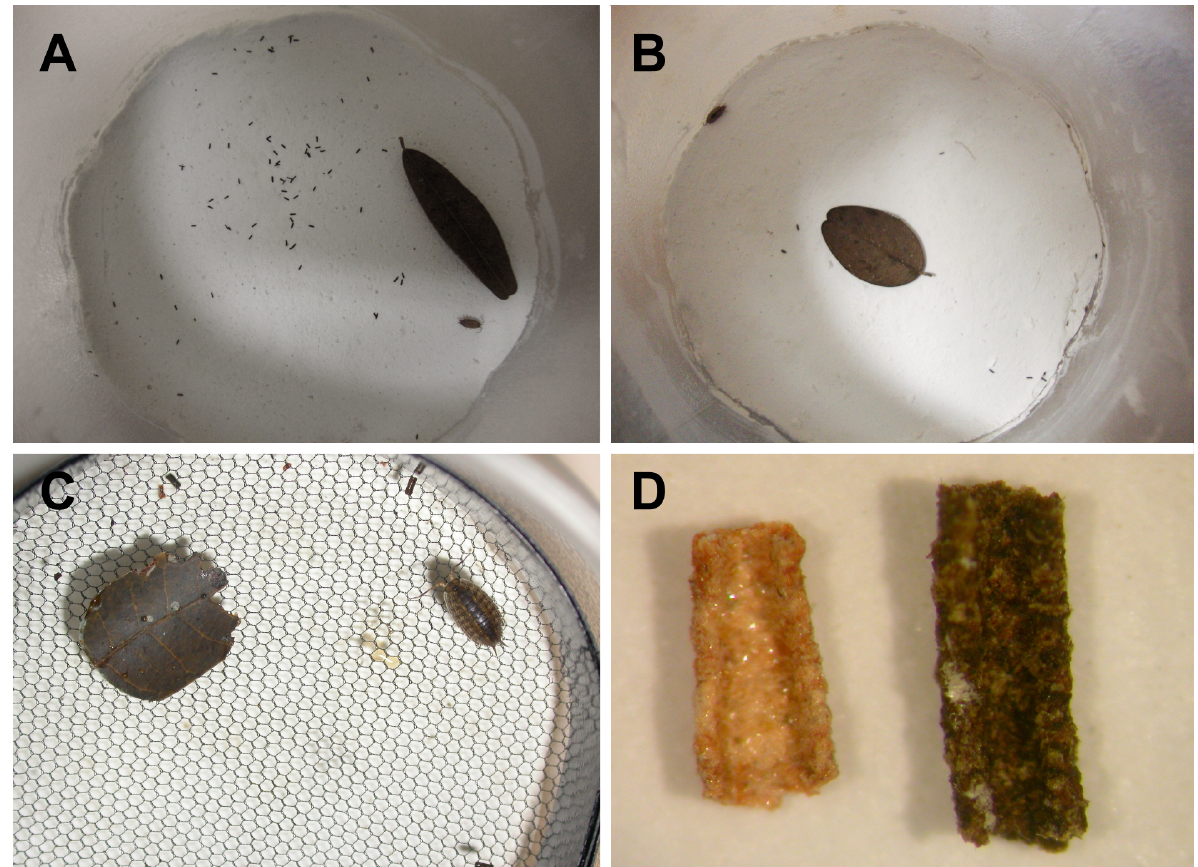
Figure 1 . Experimental units for feeding rates tests with terrestrial isopods and fecal pellets from different food sources. A ) Treatment access; coprophagy is allowed. B ) Treatment removal; coprophagy and bacterial activity on feces are avoided. C ) Treatment net; coprophagy is avoided and bacterial activity on feces allowed. D ) Fecal pellet from carrot (left) and decomposing leaf (right)